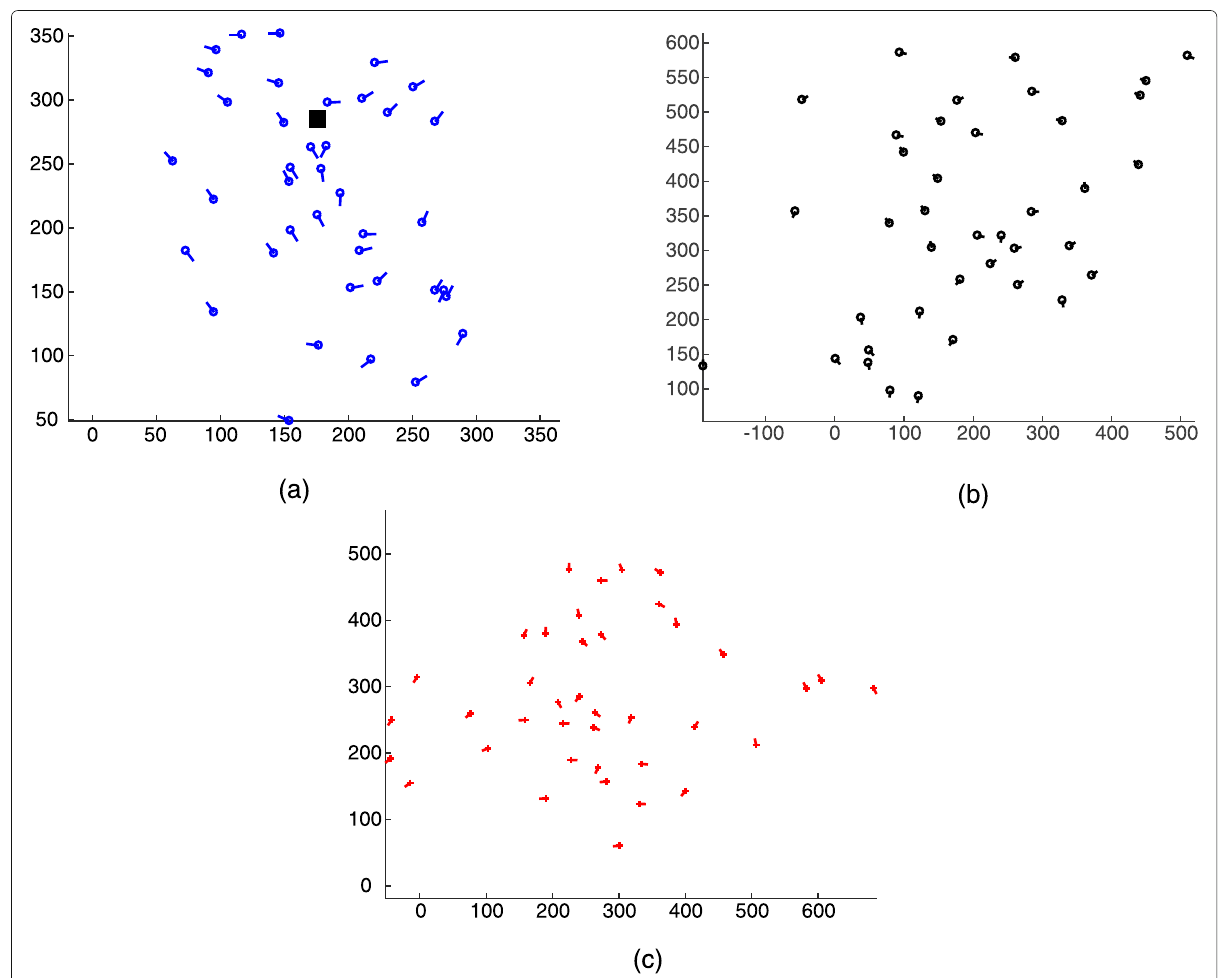
Fig. 7 Transformation of an original fingerprint template using two different sets of user key parameters. a Original template, b transformed template using the first set, and c transformed template using the second set